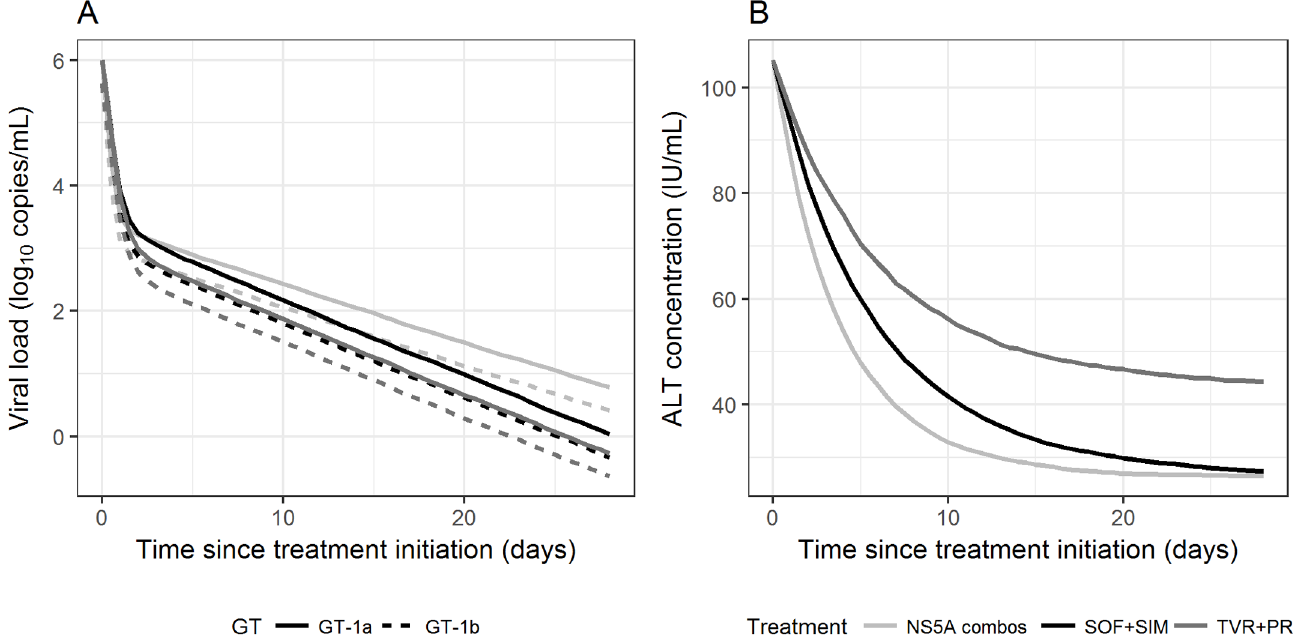
Fig 2. Predicted kinetic profiles obtained by simulations from the viral and ALT kinetic models. (panel A ) Different viral kinetics accordingto HCV-genotypes, NS5A-inhibitors and interferonadministration, (panel B ) Different ALT kinetics accordingto NS5A-inhibitors and interferon administration. ALT, alaninetransaminase; IFN,